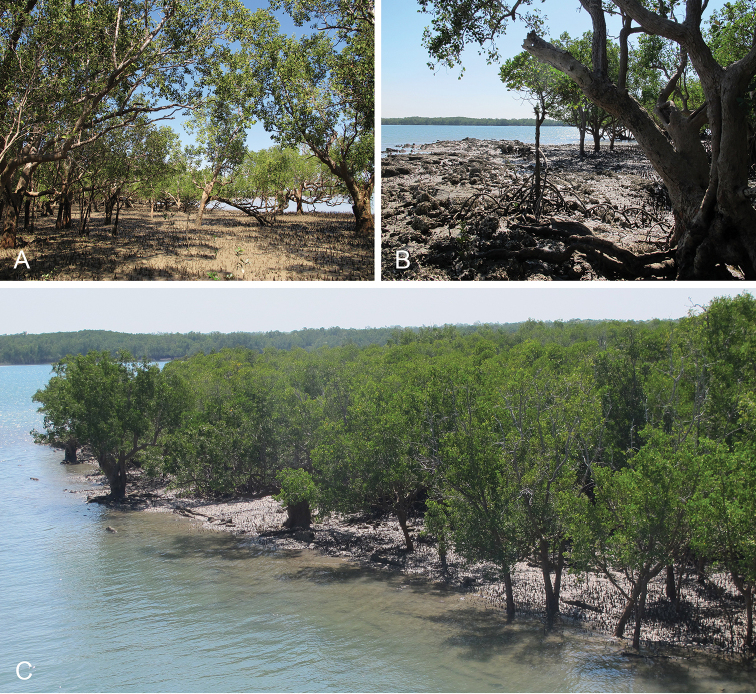
Habitats, Peronia
willani, Australia, Northern Territory A large and open forest of Sonneratia
alba with soft mud (st 62, type locality) BAvicennia mangrove with sandy mud (st 61) C view from the bridge to Channel Island, same as B.